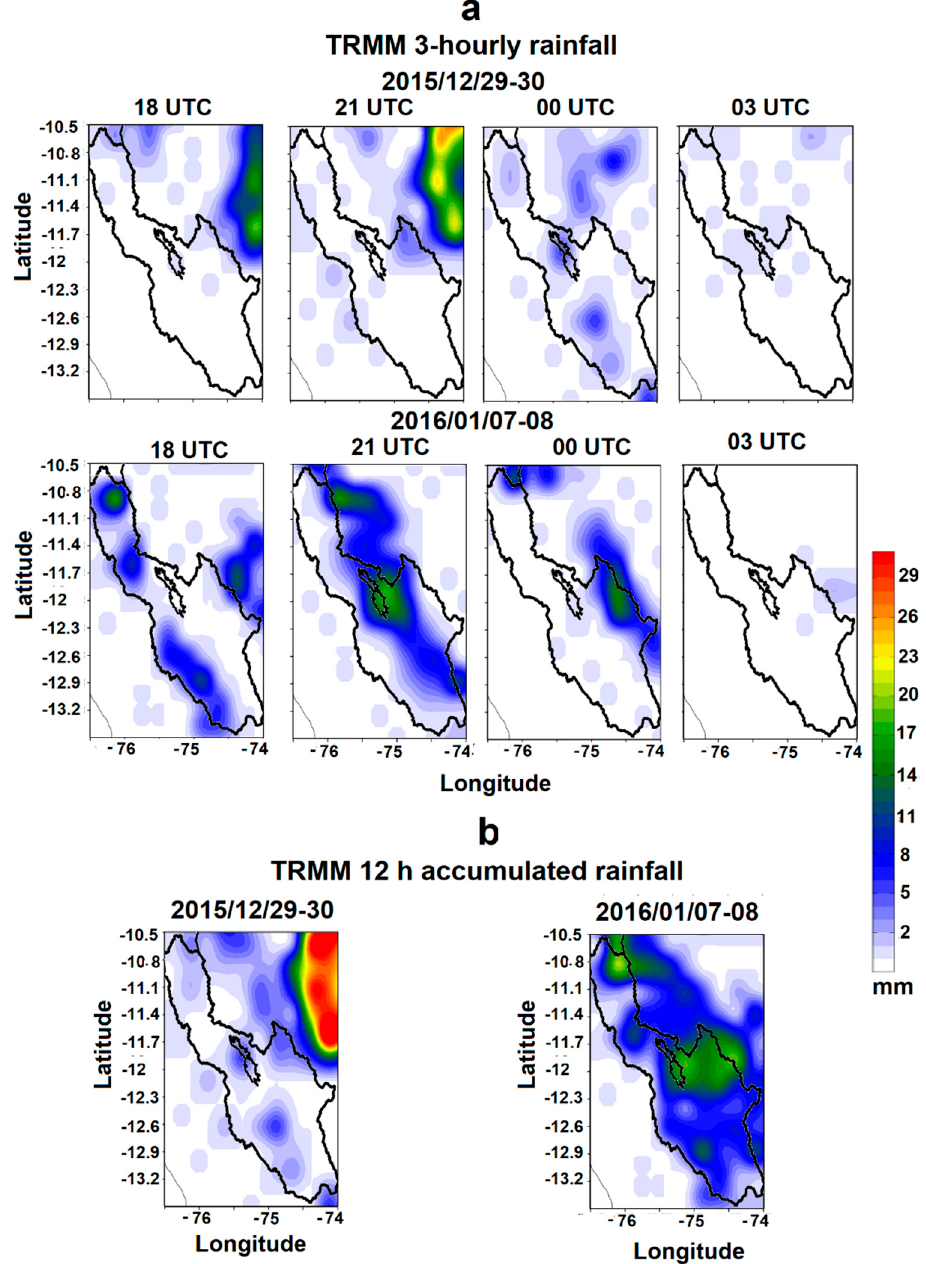
Figure 2. Evolution of surface rainfall data at each 3 h interval using the TRMM 3B42 product for the convective rainfall events ( a ) and 12 h accumulated rainfall (from 18:00 UTC to 03:00 UTC of the next day) from TRMM ( b ).